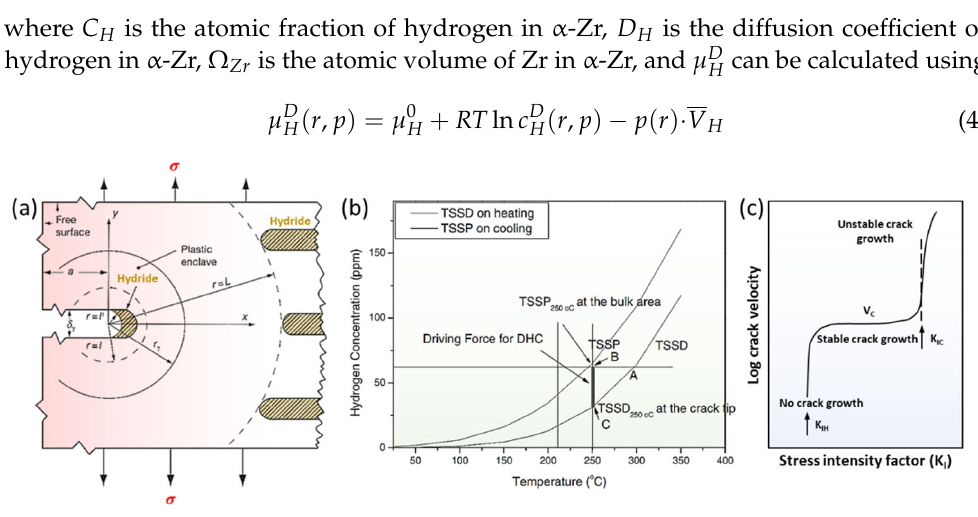
Figure 10. ( a ) Diffusion first model; ( b ) precipitation first model; ( c ) DHC velocity vs. applied stress- intensity factor [126,127]. Reprinted with permission from [126]; Copyright 2009 Elsevier. Reprinted with permission from [127]; Copyright 2008 Elsevier.